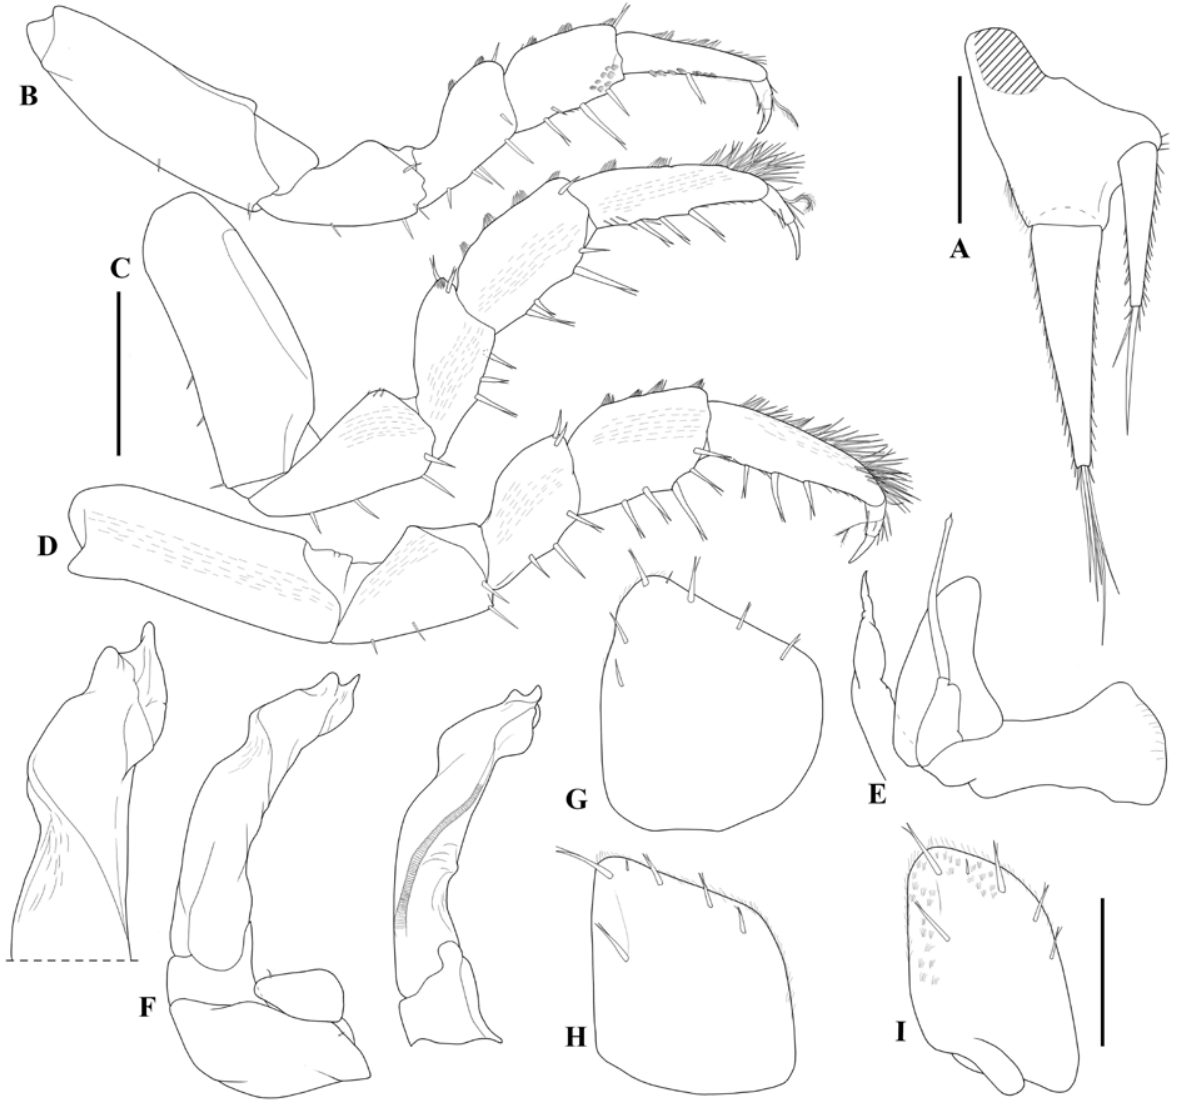
Figure 12. Pectenoniscus carinhanhensis n. sp. Male paratype: A , uropod; B , pereopod 1; C , pereopod 6; D , pereopod 7; E , genital papilla and pleopod 1; F , pleopod 2; G , pleopod 3 exopod; H , pleopod 4 exopod; I , pleopod 5 exopod. Scale bars: 0.2